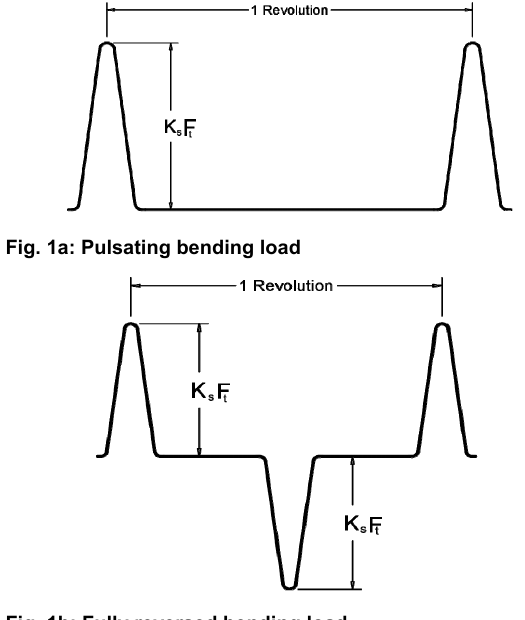
Fig. 1a: Pulsating bending load